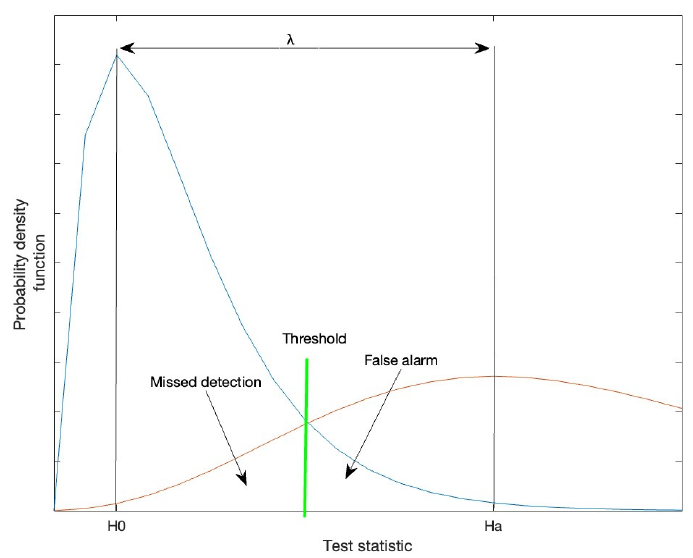
Figure 2. Central and non-central chi-square distributions used in the global Figure 2 . Central and non-central chi-square distributions used in the global test.